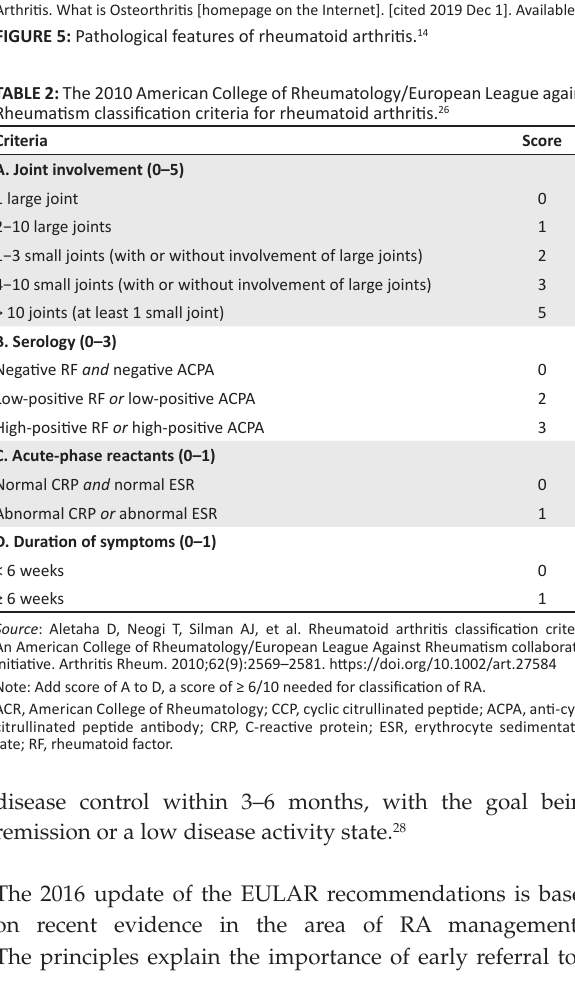
FIGURE 5: Pathological features of rheumatoid arthritis. 14